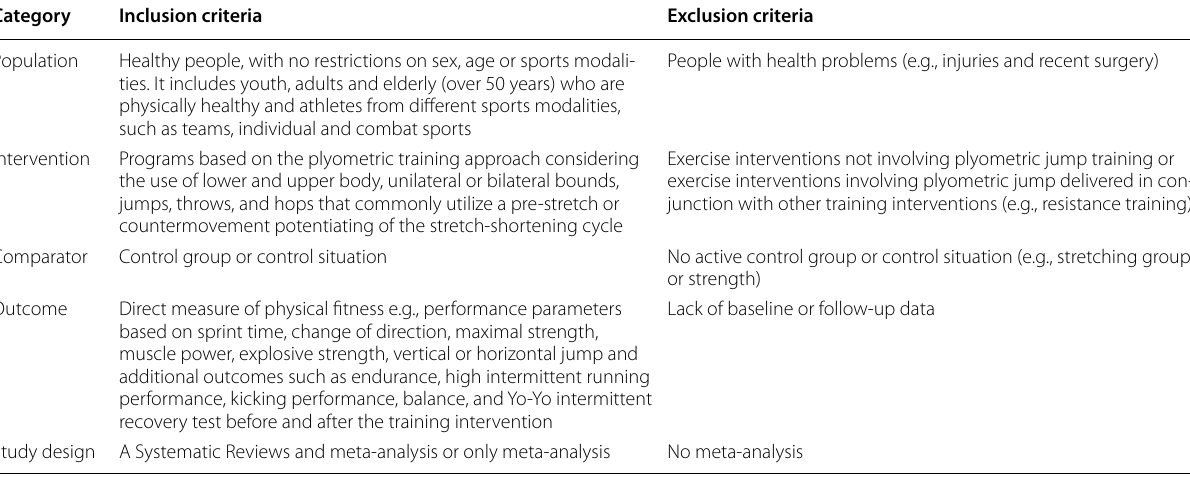
Table 1 Selection criteria used in this umbrella review Category Inclusion criteria